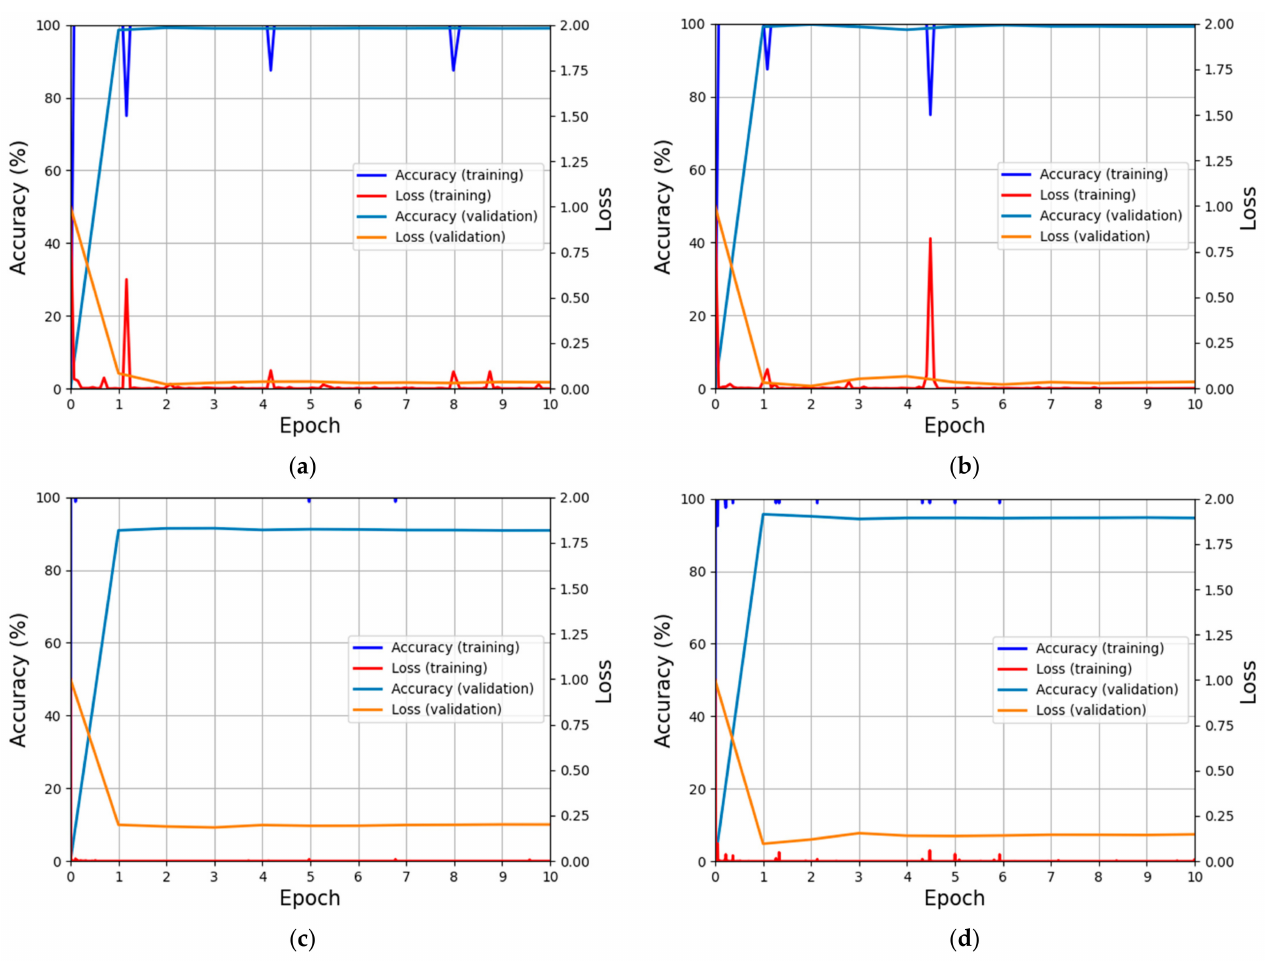
Figure 10. Training, validation loss, and accuracy graphs of SCE-Net. ( a , b ) are training and validation graphs of DBPerson-Recog-DB1 for ( a ) fold 1 and ( b ) fold 2. ( c ) and ( d ) are training and validation graphs of the SYSU-MM01 dataset for ( c ) fold 1 and ( d ) fold